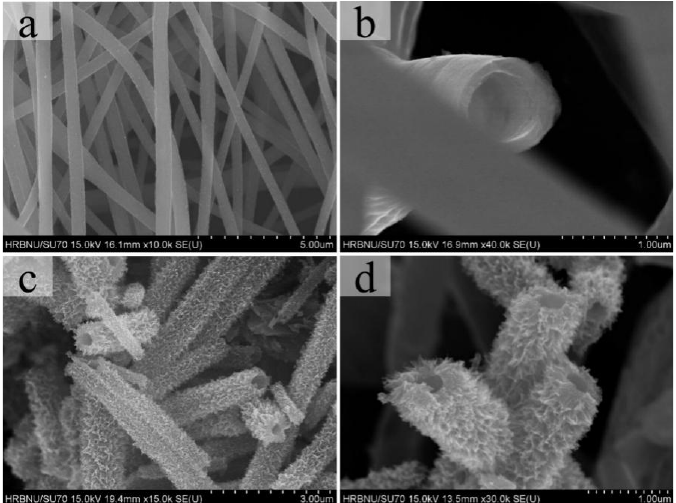
Figure 2. SEM image of ( a , b ) hollow carbon fiber, ( c , d ) CuCo 2 O 4 @CNFs.